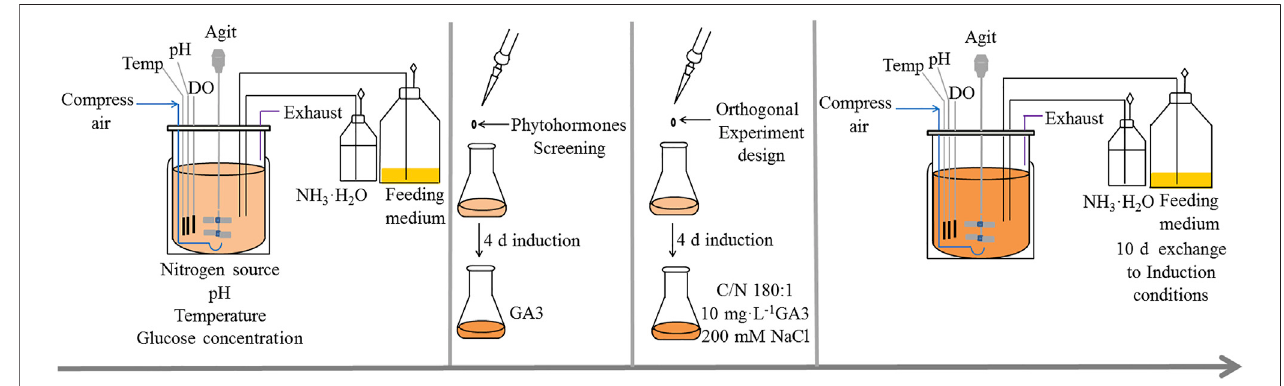
FIGURE 1 | Experimental procedures for C. zo fi ngiensis produce astaxanthin under heterotrophic conditions. The algae (with initial density of 1 – 1.5 g L − 1 ) kept growing for 10 days with the optimal heterotrophic conditions. The phytohormones screening and orthogonal experiment were conducted in Erlenmeyer fl asks to fi nd the optimal condition for astaxanthin accumulation in C. zo fi ngiensis. The induction conditions were veri fi ed in 7.5 L